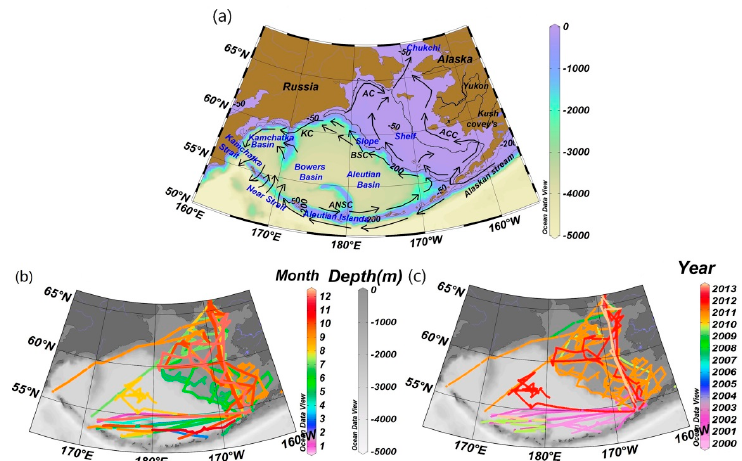
Figure 1. ( a ) The isobaths and currents in the Bering Sea (black arrows denotes current, modified from Stabeno et al. [35]; Chen et al. [4]); Data distribution in month ( b ) and year ( c ) of underway p CO 2 in the Bering Sea in 2000–2013 with the grey background of water depth. BSC: Bering Slope current; KC: Kamchatka Current; ANSC: Aleutian North Slope Current; ACC: Alaskan Coastal Current; AC: Anadyr Current.